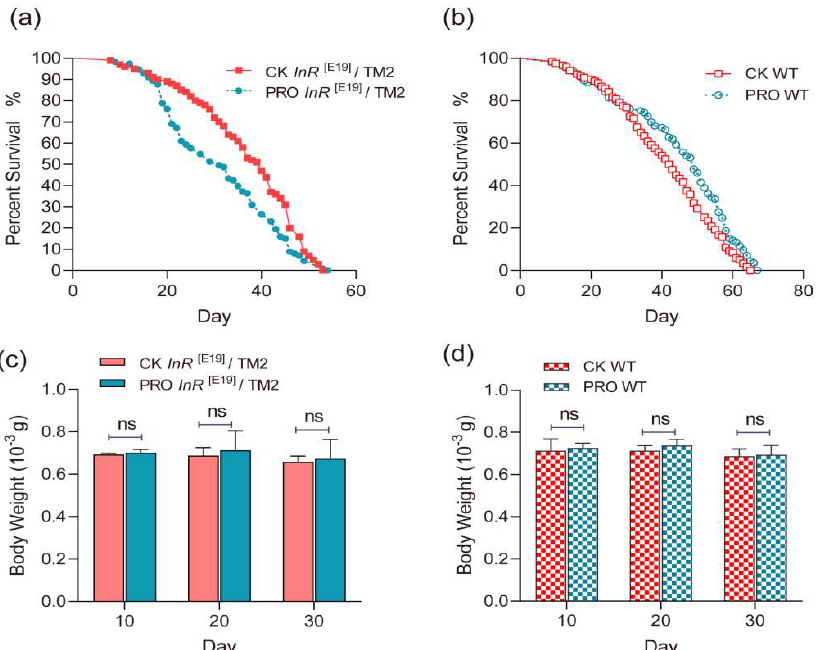
Figure 1. ( a , b ) Lifespan curves show how the probiotic treatment impacted the lifespan of the ( a ) InR [E19] /TM2 and ( b ) wild-type (WT) Drosophila . ( c , d ) Bar plot shows the body weight dynamics of the ( c ) InR [E19] /TM2 and ( d ) WT Drosophila . No significant difference was observed between the standard diet (CK) and the probiotic treatment in any sample of two groups.